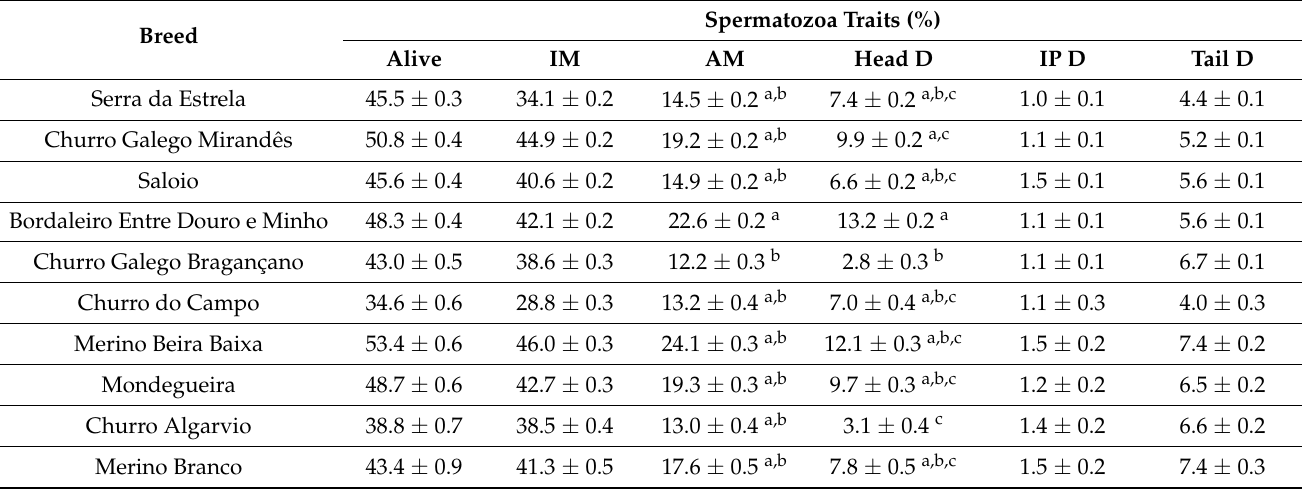
Table 6. Effects of breed and breed × semen processing interactions on spermatozoa traits of thawed